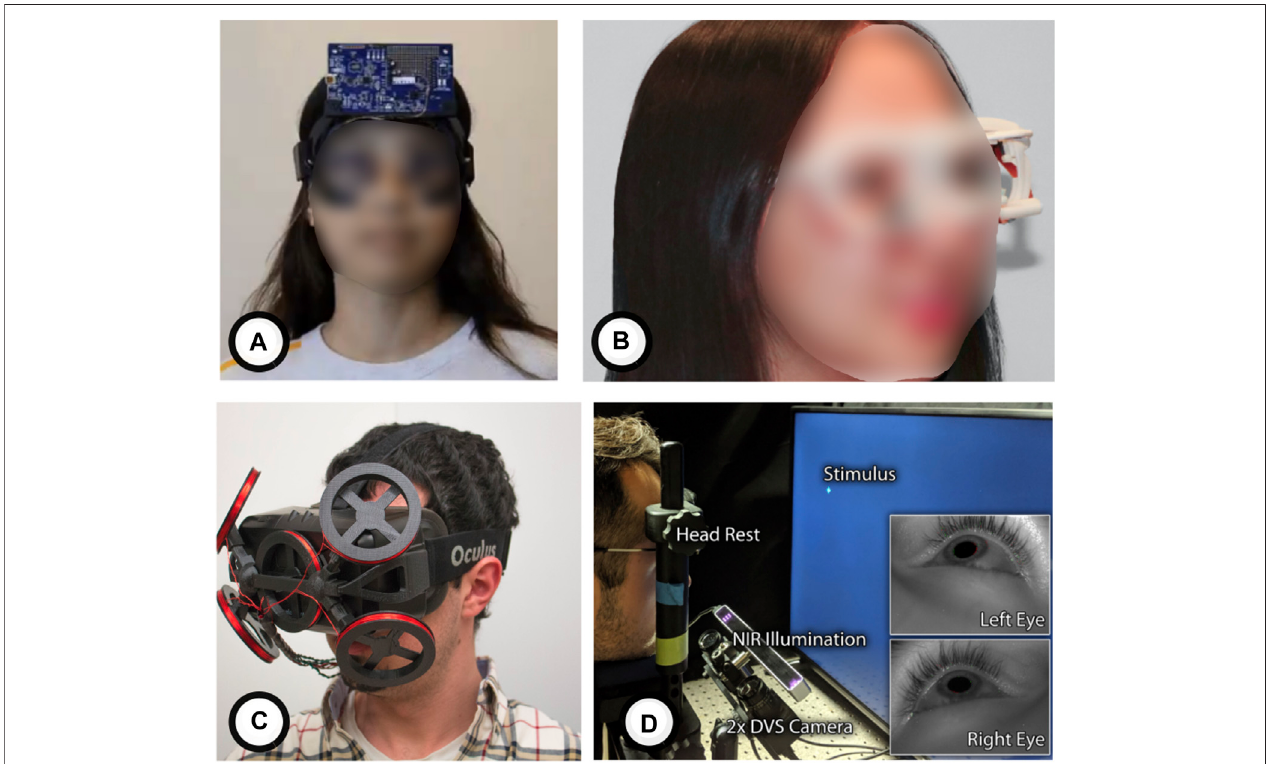
FIGURE 3 | State-of-the-art in the next generation eye and gaze tracking hardware discussed in Section 5.1: (A) Photodiode and LED based sensing (Li et al., 2020), (B) Camera based sensing (Lu et al., 2020), (C) Scleral-coil based sensing (Whitmire et al., 2016), and (D) Event camera based sensing (Angelopoulos et al., 2020). Though scleral-coil offers an invasive approach that is against our non-invasive Telelife approach, it can potentially be a good match for contact-lens augmented reality near-eye displays at a possible future.